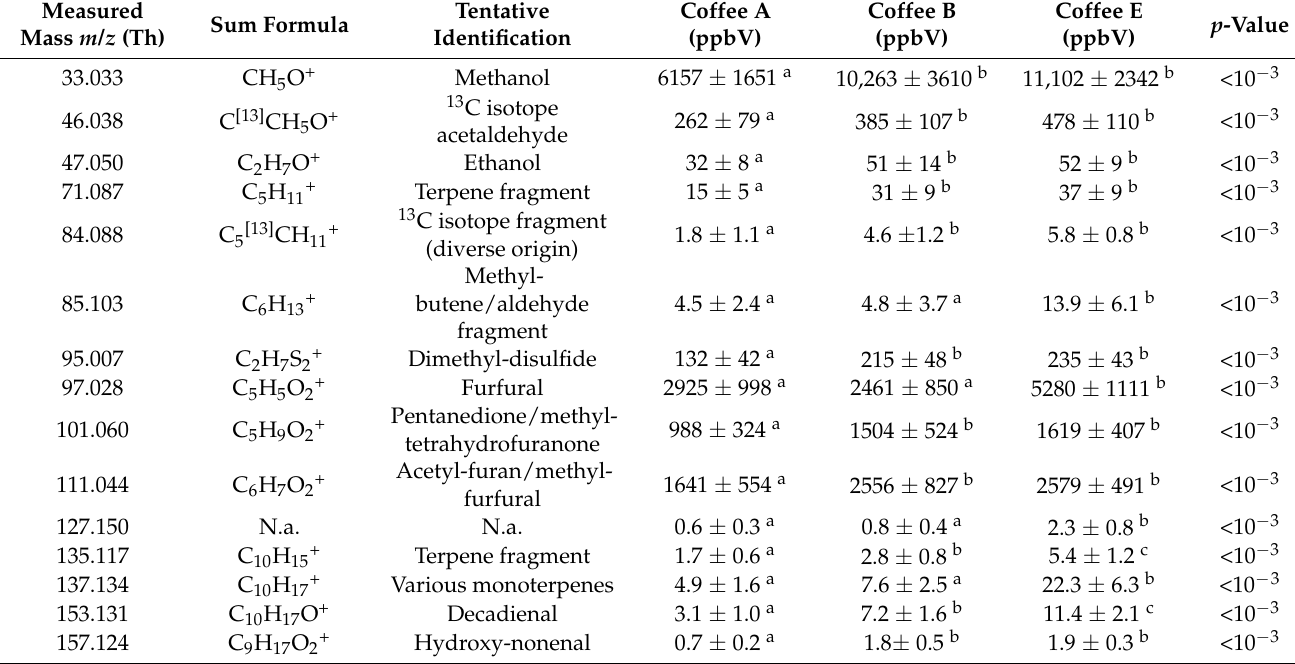
Table 2. Selected headspace mass peaks significant for discrimination (VIP > 1.5). Means and standard deviations are reported for each sample. p -values were obtained on the basis of one-way ANOVA and corrected, taking into account the false discovery rate. Superscript annotations are used to display differences between coffees; therefore, when two values are annotated by different letters, this denotes the pairwise statistically significant difference (Tukey’s